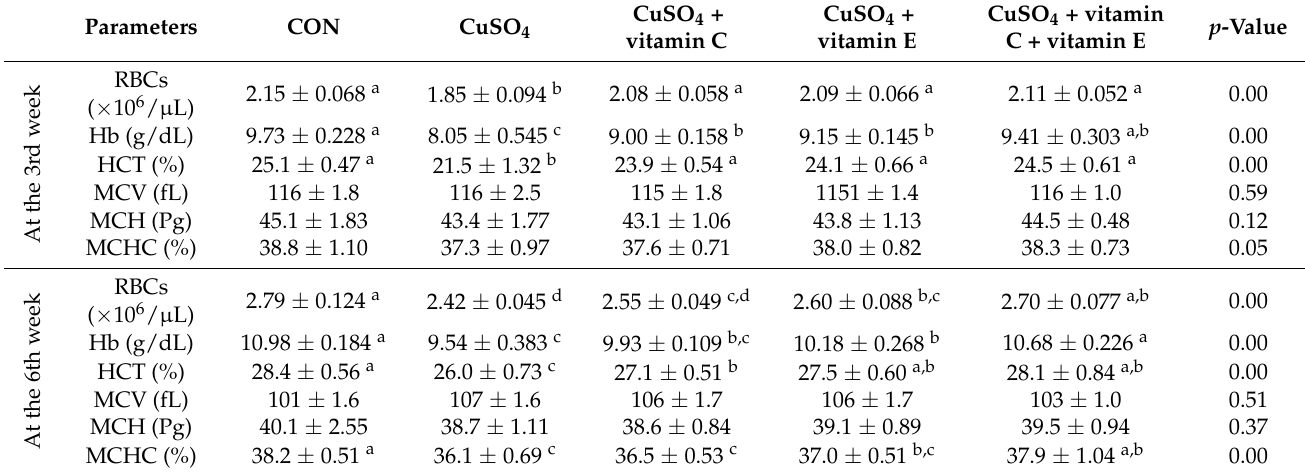
Table 2. Impact of single or combined supplementation of vitamin C and E on the erythrogram of CuSO 4 -intoxicated broiler chickens (mean ± SD, n = 5).